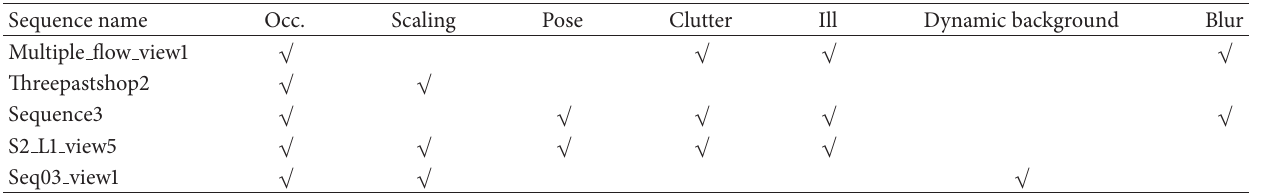
Figure 3: Separating merged objects and locating them with the probability distribution. Table 1: The challenges of the experimental sequences.